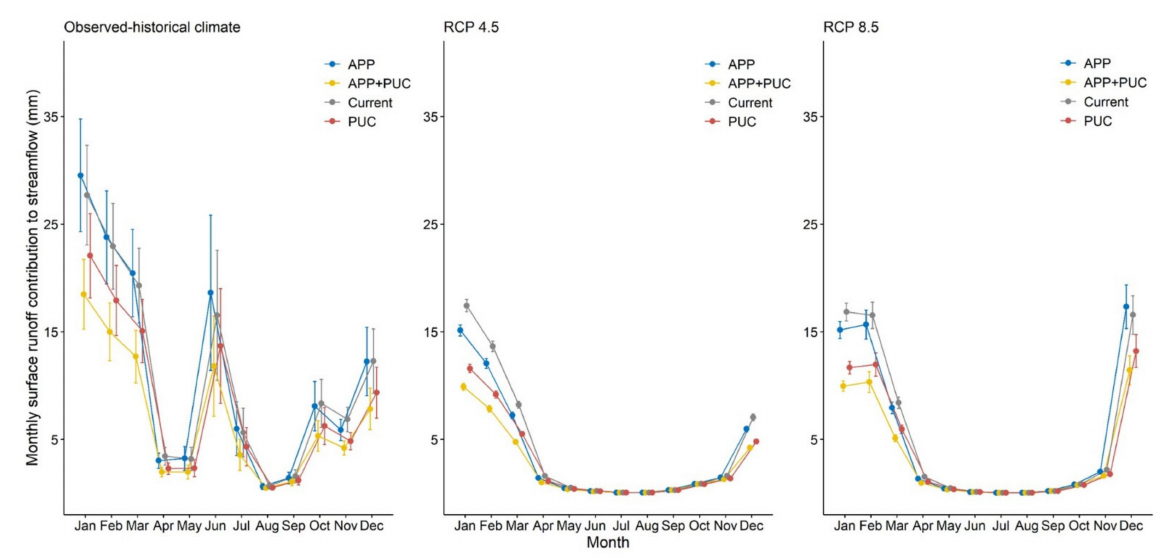
Figure 8. Monthly mean surface runoff for each LULC scenario (i.e., Current; APP = riparian restoration; PUC = focal conservation; APP + PUC = combined solution) in each climate condition for the entire simulation period: observed historical = average for each month of the year for the years 2012 to 2019; RCP 4.5 and RCP 8.5 = average for each month of the year for the years 2020 to